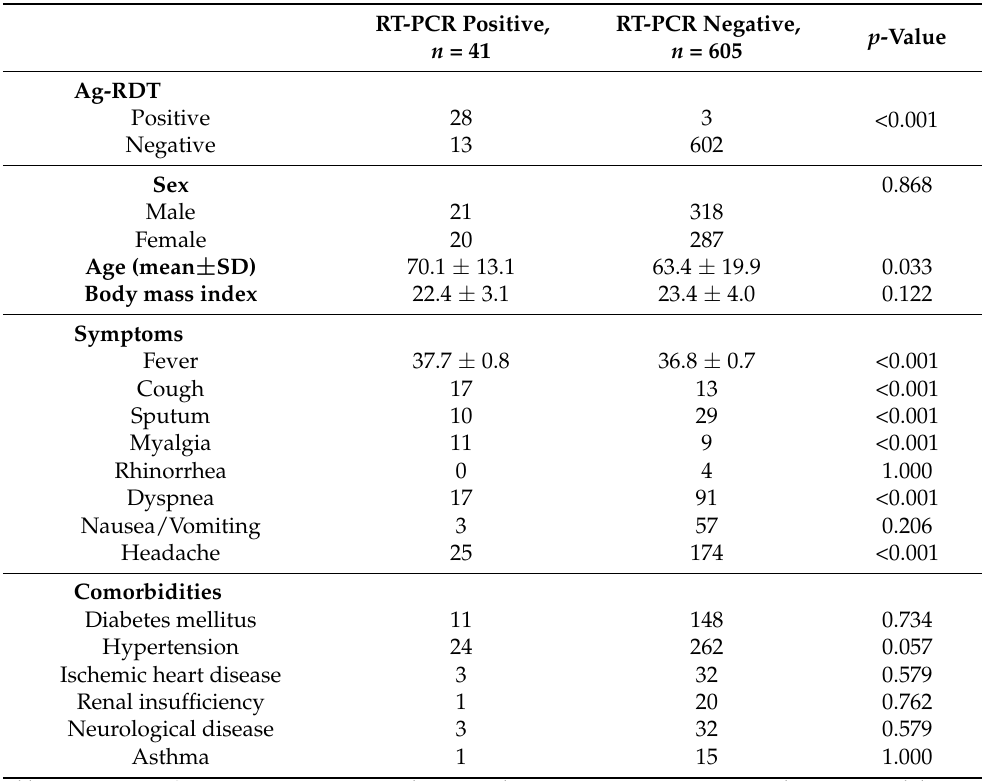
Table 1. Results of demographics, antigen-detecting rapid diagnostic test in admitted patients.